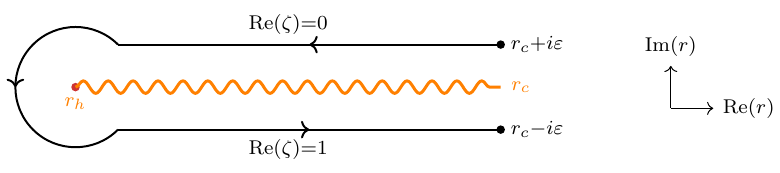
Figure 1 . The complex r plane with the locations of the two boundaries and the horizon marked. The grSK contour is a codimension-1 surface in this plane (drawn at fixed v ). As indicated the direction of the contour is counter-clockwise and it encircles the branch point at the